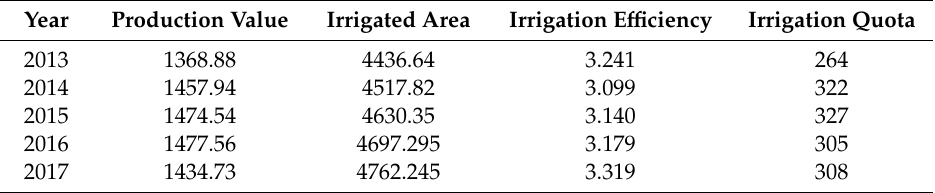
Table 5. Agricultural production data in Inner Mongolia from 2013 to 2017.